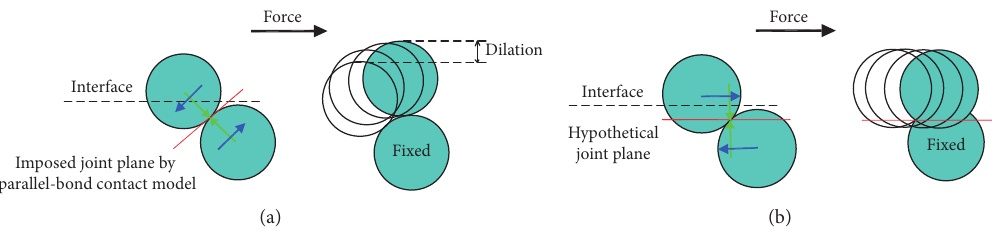
Figure 2: The movement direction of balls in (a) a parallel-bond contact model and (b) a smooth joint contact model (Mehranpour and Kulatilake [27]). Table 1: Microparameters for simulating rock and grout.